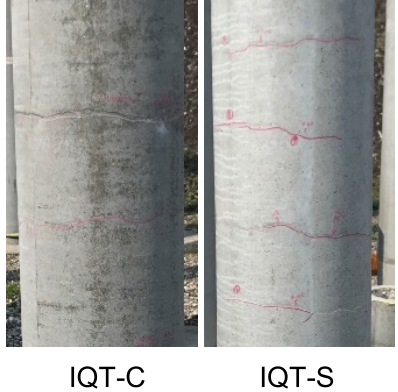
Figure 11. Results of external observation of CP500 utility poles exposed to bending for 5.9kN for 10 years.